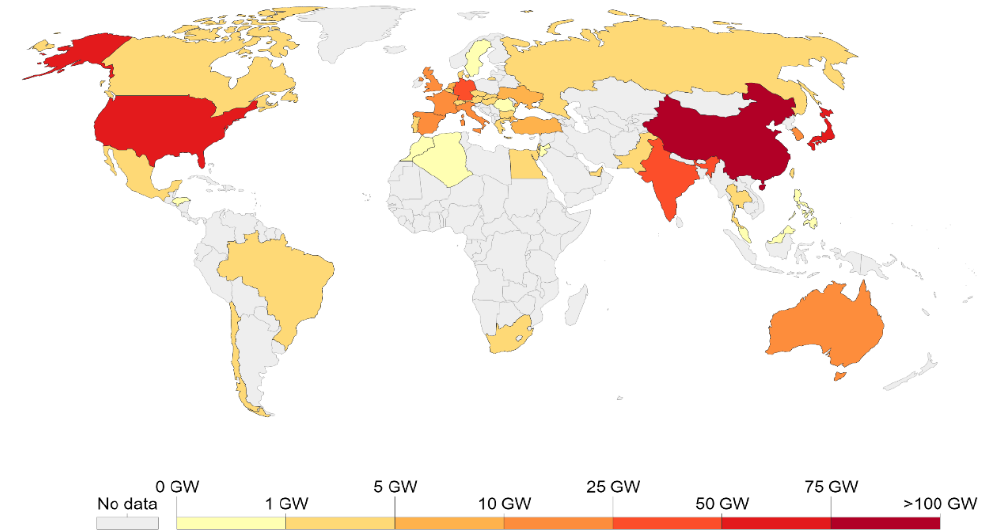
Figure 4. A global map highlights the cumulative installed solar photovoltaic capacity, measured in gigawatts (GW) [62]. (Data Source: British Petroleum (BP) Statistical Review of World Energy, 2020).